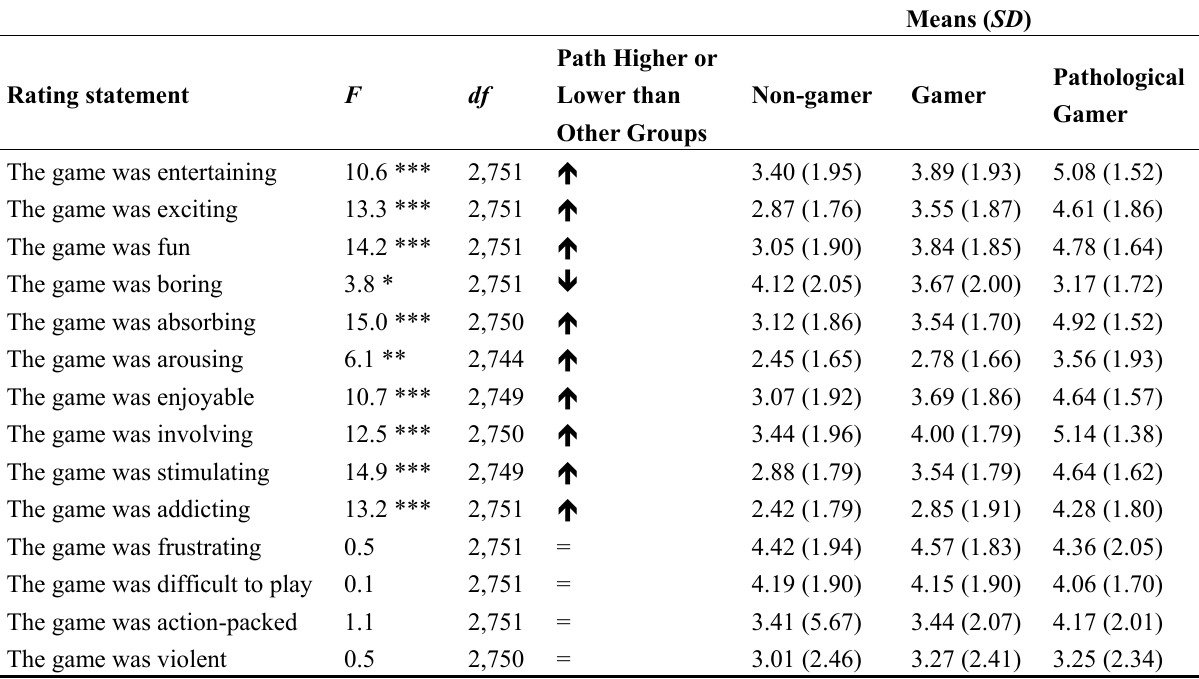
Table 6. ANOVAs of video game evaluation ratings split by gamer type (Study 3).